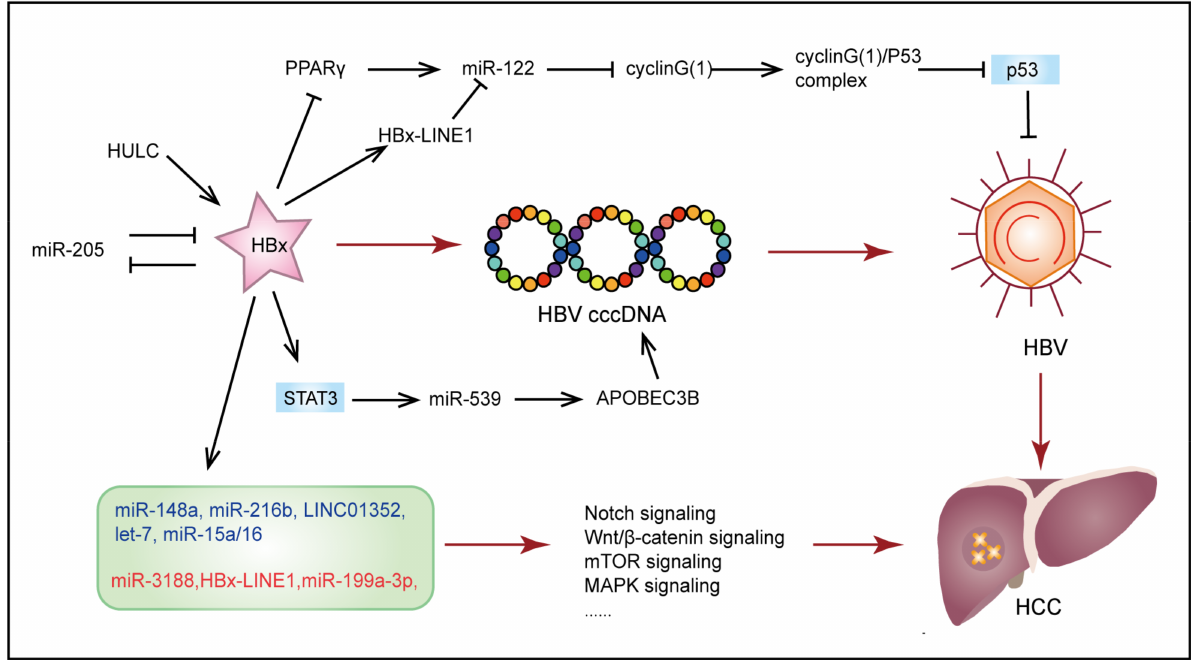
Figure 3. A schematic diagram of the role of ncRNAs in HBV-induced hepatocellular carcinoma. A negative feedback loop is formed between miR-205 and HBx. HULC/HBx/STAT3/miR-539/APOBEC3B signaling is involved in enhancing the stability of HBV cccDNA, thereby promoting HBV replication. The dysregulation of miR-122 is involved in eliminating p53- mediated inhibition of HBV replication. The ncRNAs in the light green rounded rectangle are believed to be dysregulated by HBx. Among them, the expression of ncRNAs in dark blue is inhibited by HBx, while the expression of ncRNAs in red is promoted. Dysregulated ncRNAs participate in the activation of oncogenic pathways, thereby promoting the occurrence and development of